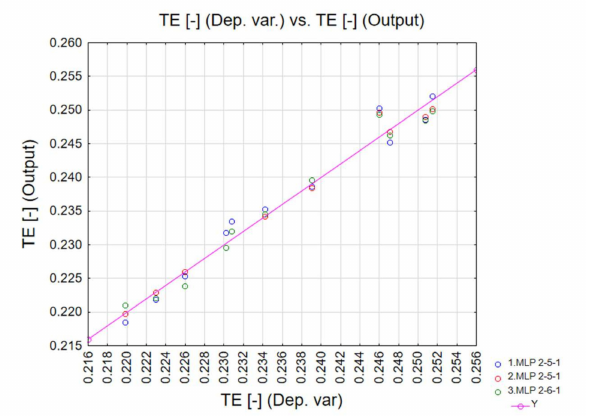
Figure 18. TE neural network training quality.